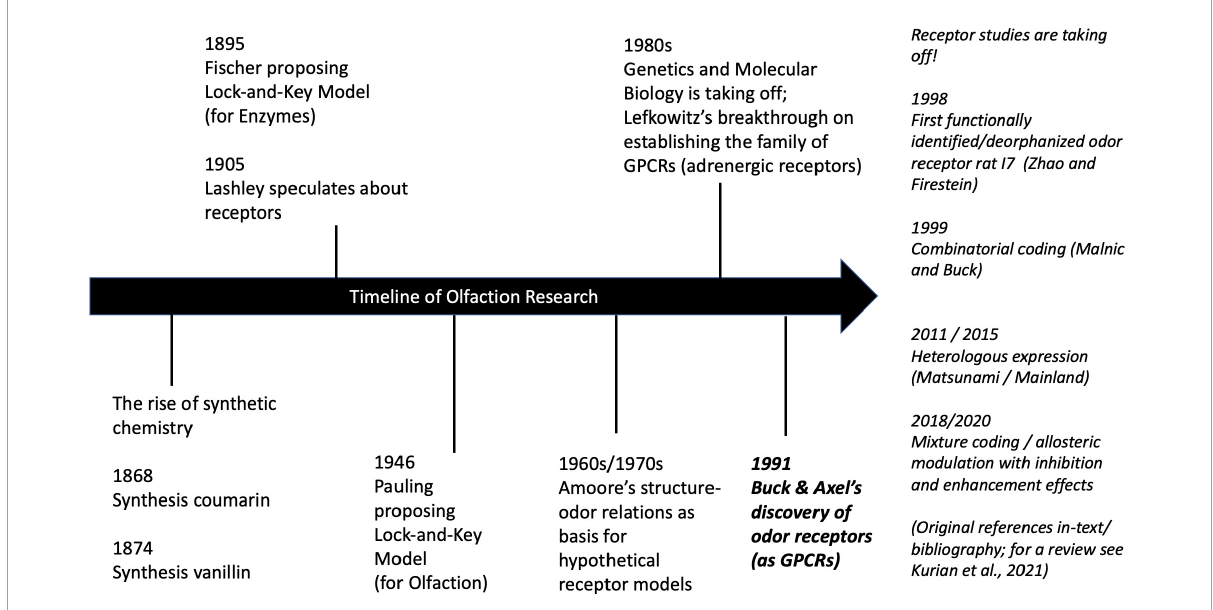
FIGURE2 Historical timeline of selected key events in olfaction research (with focus on receptor biology). For details on the history of olfaction see Barwich (2020a, Ch. 1; biology-centered); and Ohloff et al. (2012, Ch. 1; chemistry-centered). For details on the history of genetics see Kay (2000) and GPCRs see Barwich and Bschir (2017). For a review of current research on odor coding mechanisms see Kurian et al.